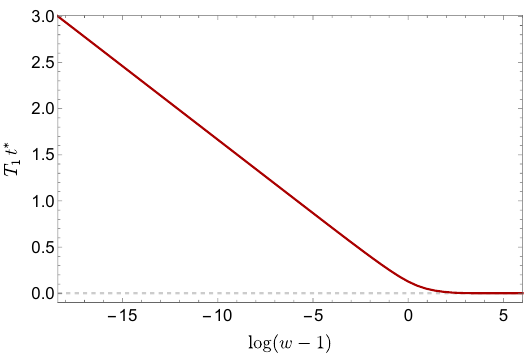
Figure 20. Characteristic time of crossing between the two regimes in the complexity of formation in which the slopes are proportional to the di(cid:11)erence of the masses, see eq. (4.38), and the sum of the masses, see eq. (4.39). The logarithmic dependence on the energy of the shock in this plot is another diagnostic of the scrambling time (cf. (cid:12)gure 18, right panel) and matches closely the (cid:12)t in eq.